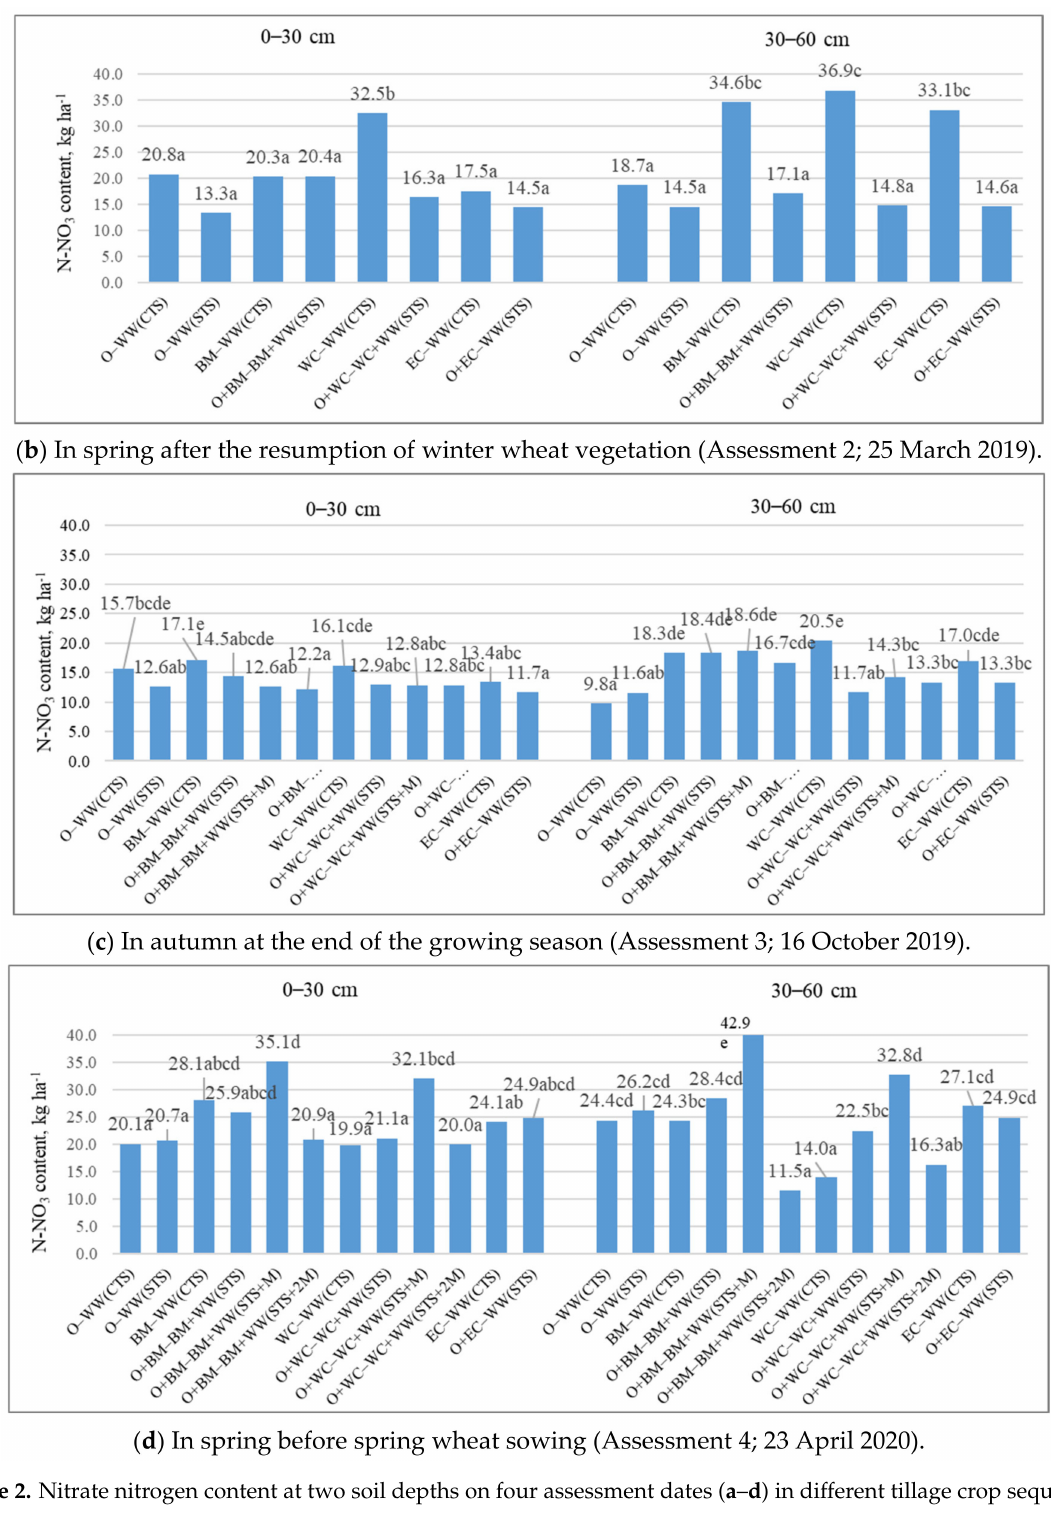
Figure 2. Nitrate nitrogen content at two soil depths on four assessment dates ( a – d ) in different tillage crop sequences. Winter wheat management strategies: O-WW(CTS)–oat–winter wheat (conventional tillage and sowing); O–WW(STS)–oat–winter wheat (strip tillage and sowing); BM-WW (CTS)–black medick–winter wheat (conventional tillage and sowing); O+BM–BM+WW(STS) –oat undersown with black medick–black medick and winter wheat intercrop (strip tillage and sowing); O+BM–BM+WW(STS+M)–oat undersown with black medick–black medick and winter wheat intercrop (strip tillage and sowing, mulching once);